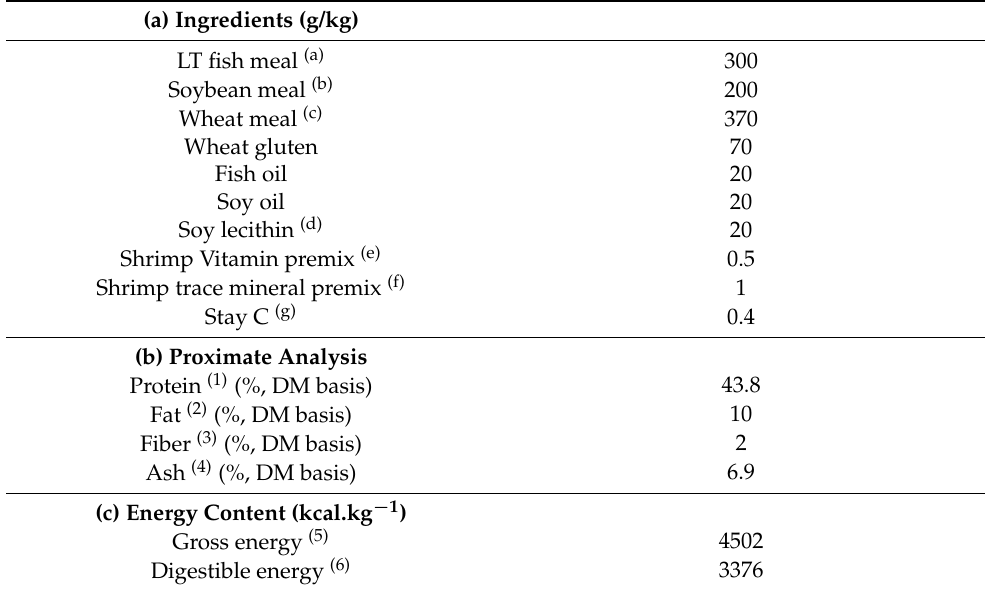
Table 1. ( a ) Raw material composition, ( b ) proximate composition and ( c ) energy content of the basal experimental diet.